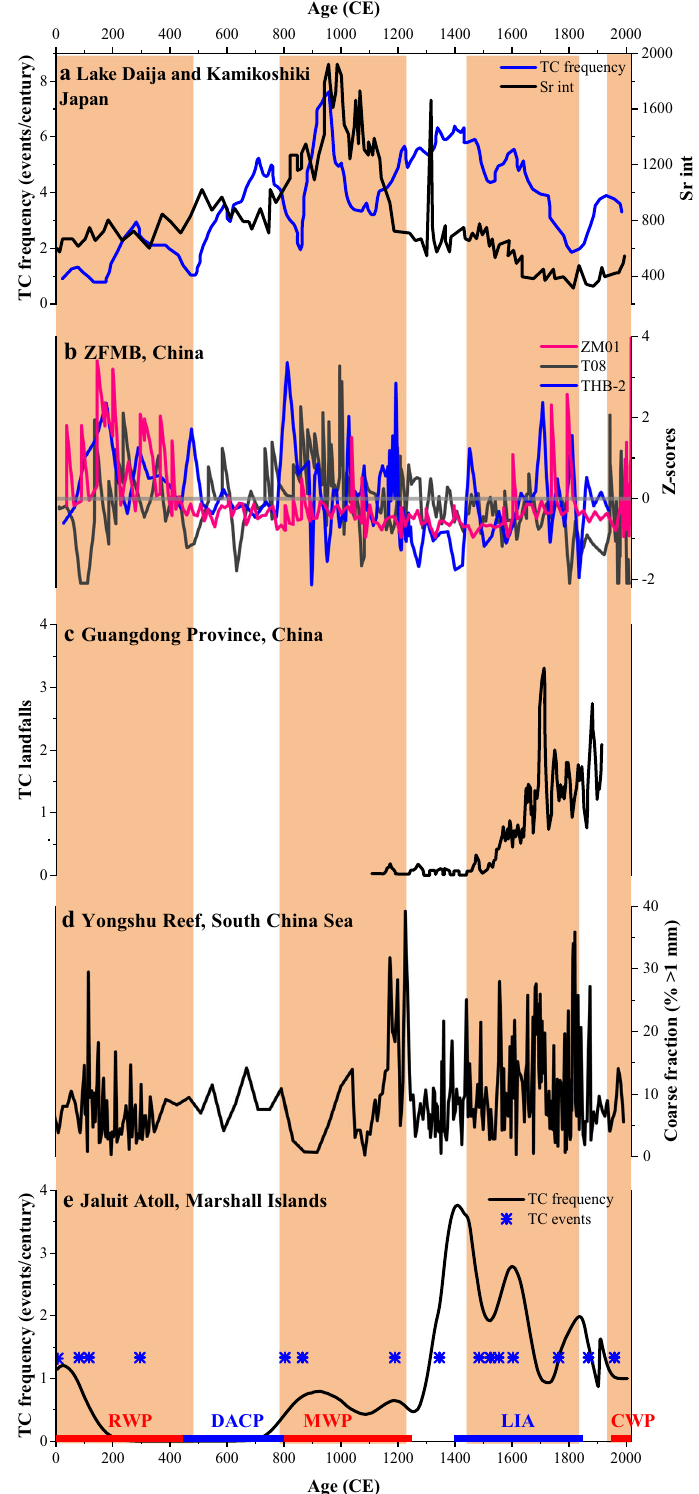
Fig. 5 Tropical cyclone reconstructions for the northwestern Paci fi c. a TC frequency reconstructions from Lake Daija (events/century) 55 and Kamikoshiki (Sr proxy) 18 , Japan. b Sand content from cores ZM01, T08 25 , and THB-2 38 in the ZFMB. c Documented TC landfalls in Guangdong Province 27 . d Coarse- grained fractions of large wave deposits at Yongshu Reef, South China Sea 54 . e Centennial frequency of identi fi ed storm deposits from Jaluit Atoll, Marshall Islands 30